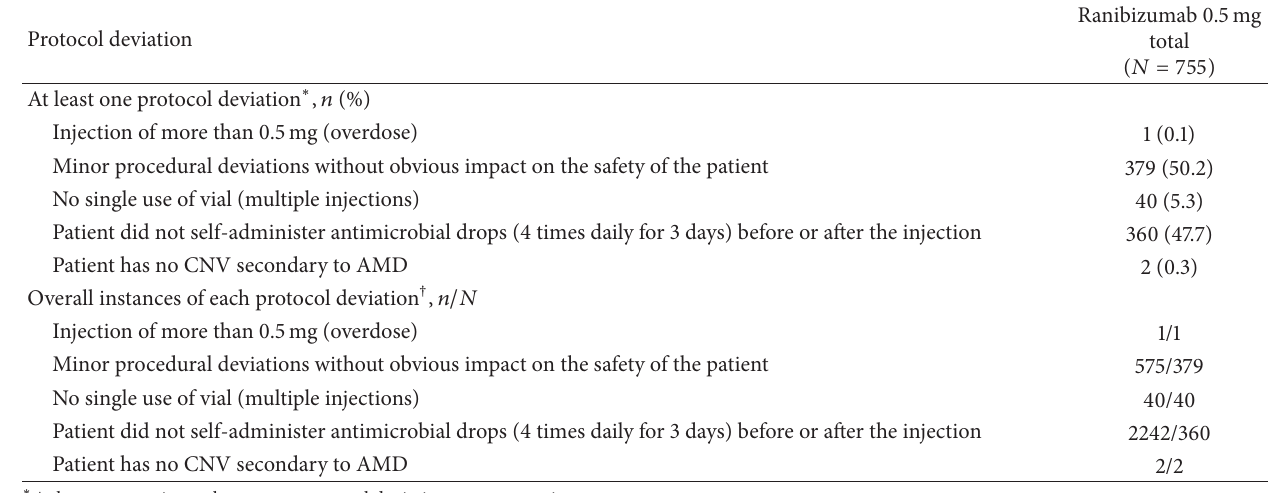
Table 2: Protocol deviations with respect to treatment compliance over 2 years.